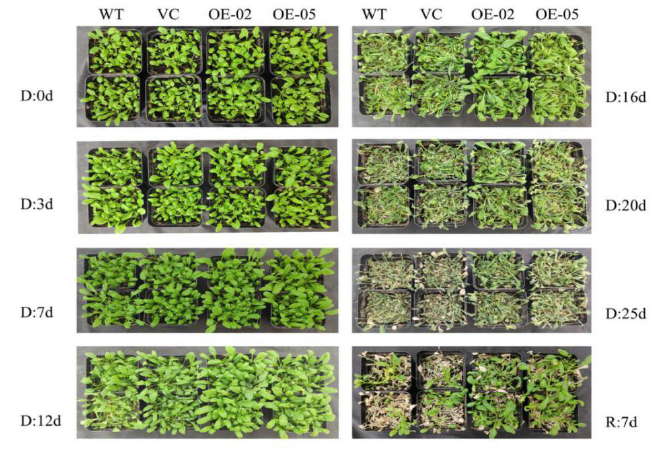
Figure 5. The phenotype of TaGApC2-6D over-expressing Arabidopsis plants after withholding water for 25 days. D, drought; R, re-watered; WT, wild